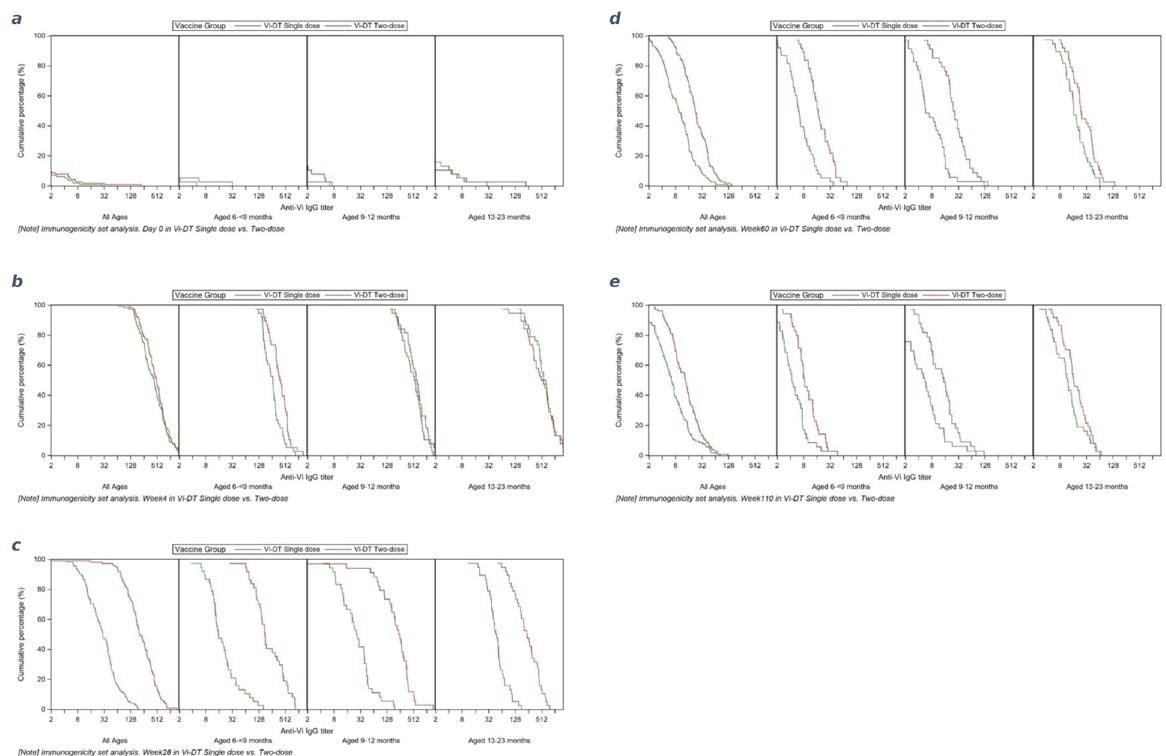
Fig. 3 a – e : Reverse cumulative distribution curves (RCDC) showing anti-Vi IgG titers at prede fi ned timepoints. a RCDC of the geometric mean titers in the three treatment groups at baseline. b RCDC of the geometric mean titers in the three treatment groups at 4 weeks. c RCDC of the geometric mean titers in the three treatment groups at 28 weeks. d RCDC of the geometric mean titers in the three treatment groups at 60 weeks. e RCDC of the geometric mean titers in the three treatment groups at 110 weeks. The y axis in each RCDC represents the cumulative percentage of participants who had the measured corresponding geometric mean titer (GMTs) (IU/L) displayed on the x axis for each visit. The x axis represents the GMTs measured for the respective visit for all ages and disaggregated by age.